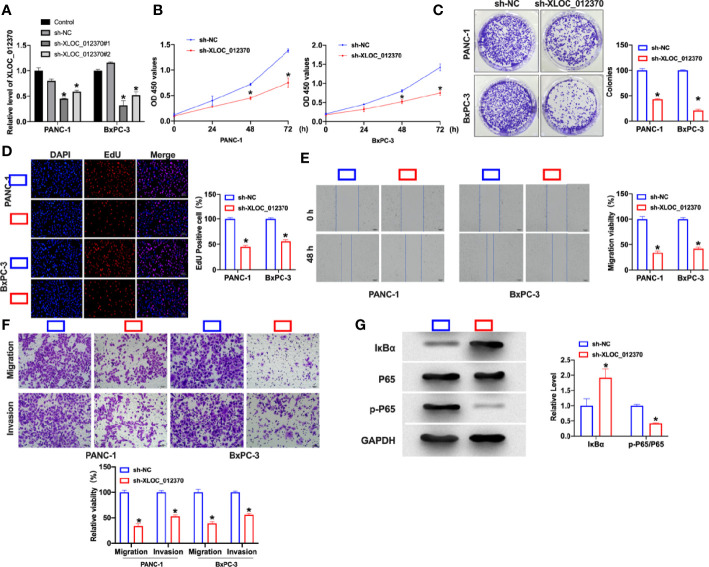
Silencing of XLOC_012370 promotes proliferation, migration, and invasion in PANC-1 and BxPC-3 cells. (A) Efficiencies of XLOC_012370 knockdown in PANC-1 and BxPC-3 cells were detected by qRT-PCR assays. n=5, *P < 0.05. (B) The cell viability of sh- XLOC_012370-transfected PANC-1 and BxPC-3 cells were detected by CCK-8 assays. n=6, *P<0.05. (C) Effect of XLOC_012370 knockdown on colony formation was counted in PANC-1 and BxPC-3 cells. n=4, *P < 0.05. (D) Representative images and histogram analysis of EdU assays after XLOC_012370 knockdown in PANC-1 and BxPC-3 cells. n=3, *P <0.05. (E) Wound healing assays after XLOC_012370 knockdown in PANC-1 and BxPC-3 cells. n=3, *P < 0.05. (F) Representative images and histogram analysis of transwell assays after XLOC_012370 knockdown in PANC-1 and BxPC-3 cells. n=4, *P < 0.05. (G) The protein level of IκBα, P65, and p-P65 were detected in PANC-1 cells.